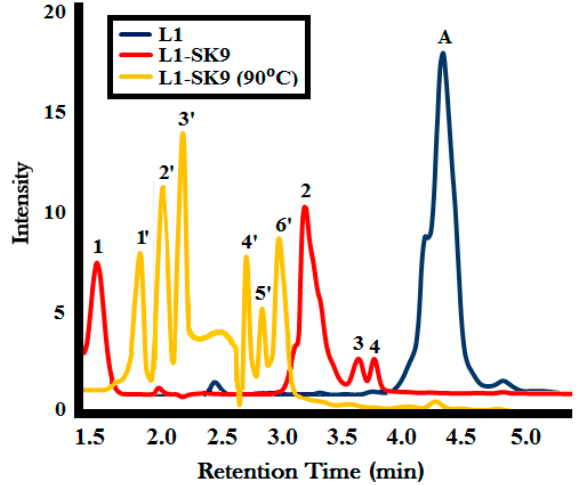
Figure 19. Gas spectrum (GC) of lignin ( L1 ) and lignin depolymerization products L1-SK9 and L1- SK9 ( 90 °C ); Samples after 60 min of photocatalytic activity under UV light at room temperature and at 90 °C, respectively. Table 7. GC-MS data of the lignin depolymerization products L1-SK9 and L1-SK9 ( 90 °C ). GC Peak No.